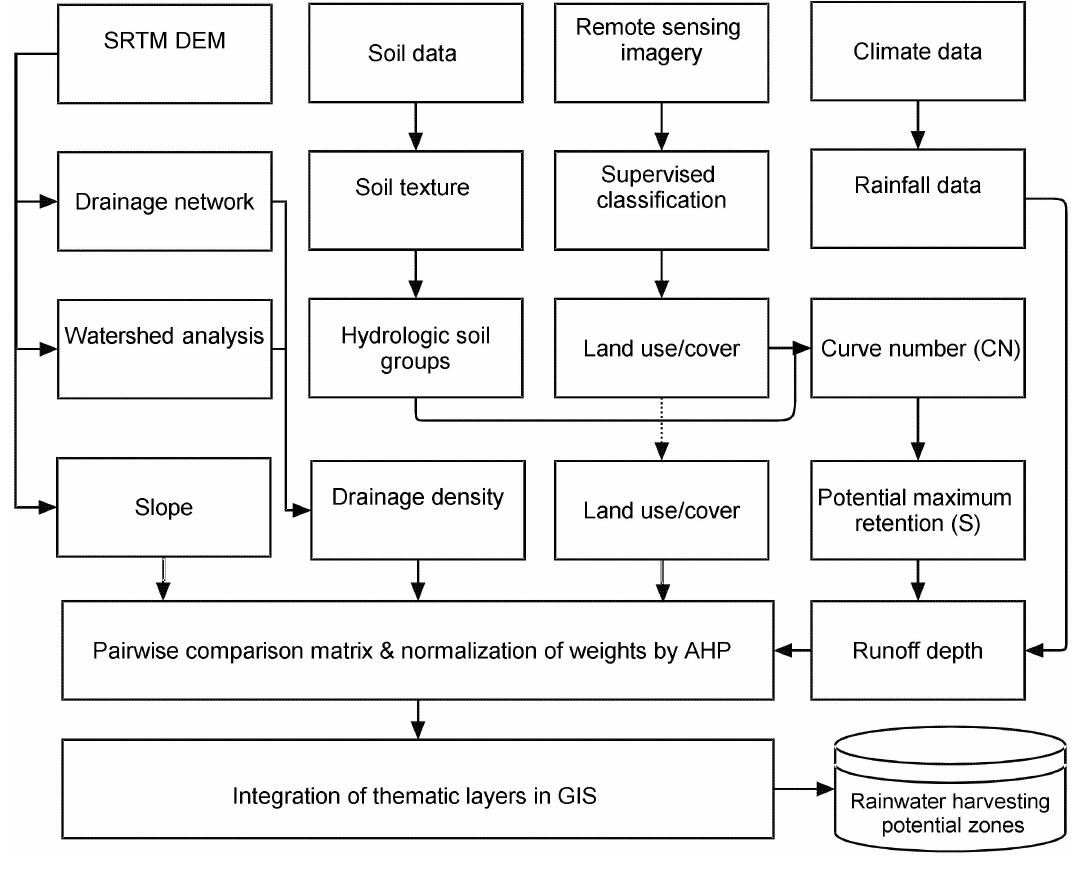
Figure 5. Flow chart showing the adopted